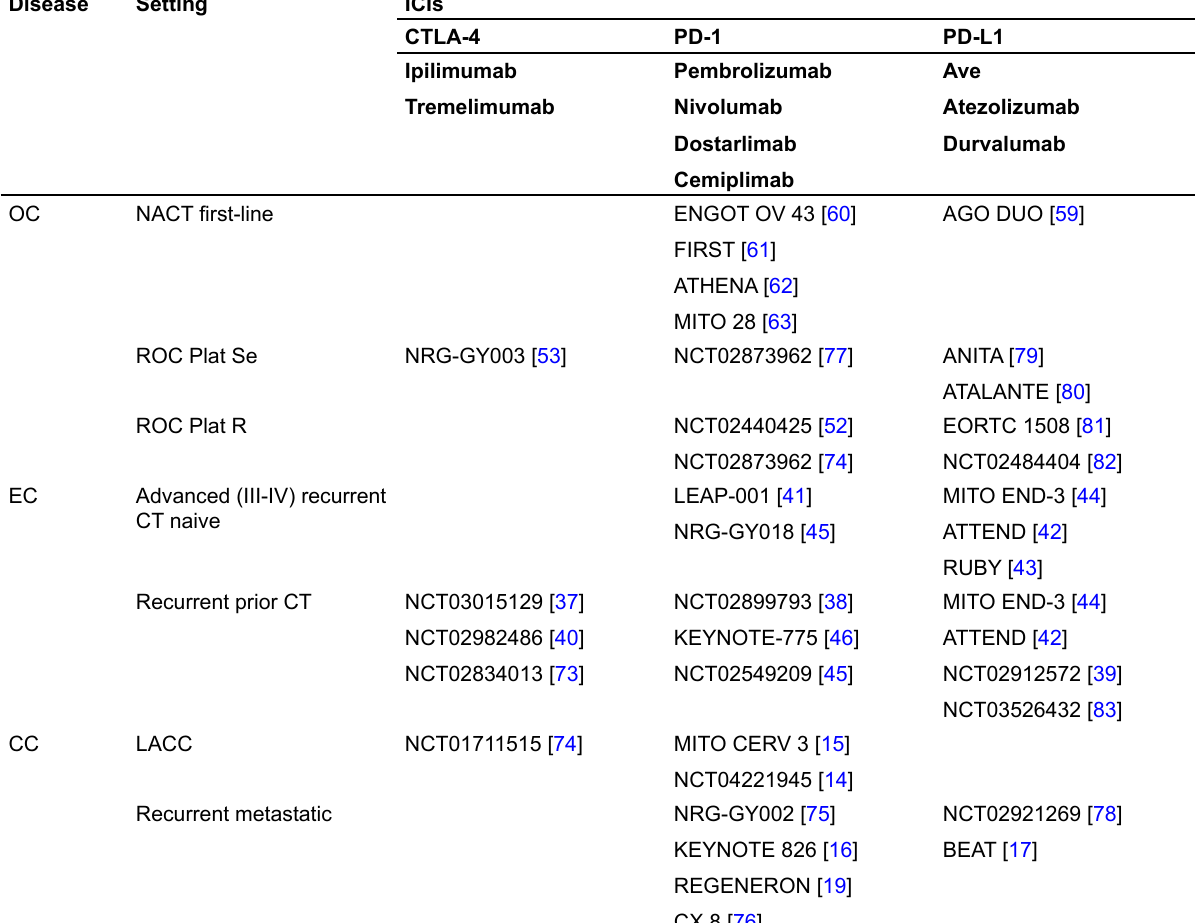
Table 4. Clinical trials on ICIs in gynecological malignancies Disease